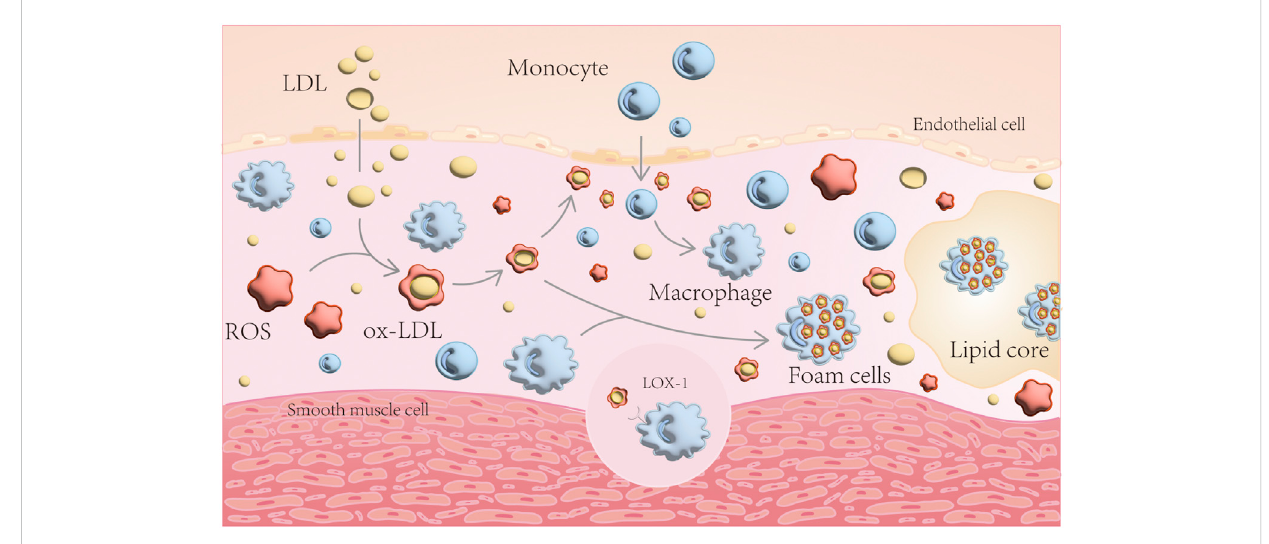
Schematic diagram of AS formation mechanism. LDL enters the subendothelium and undergoes ROS oxidation to become ox-LDL. ox-LDL damages the endothelium, allowing monocytes to enter the inner membrane and differentiate into macrophages, which engulf ox-LDL in large quantities, forming foam